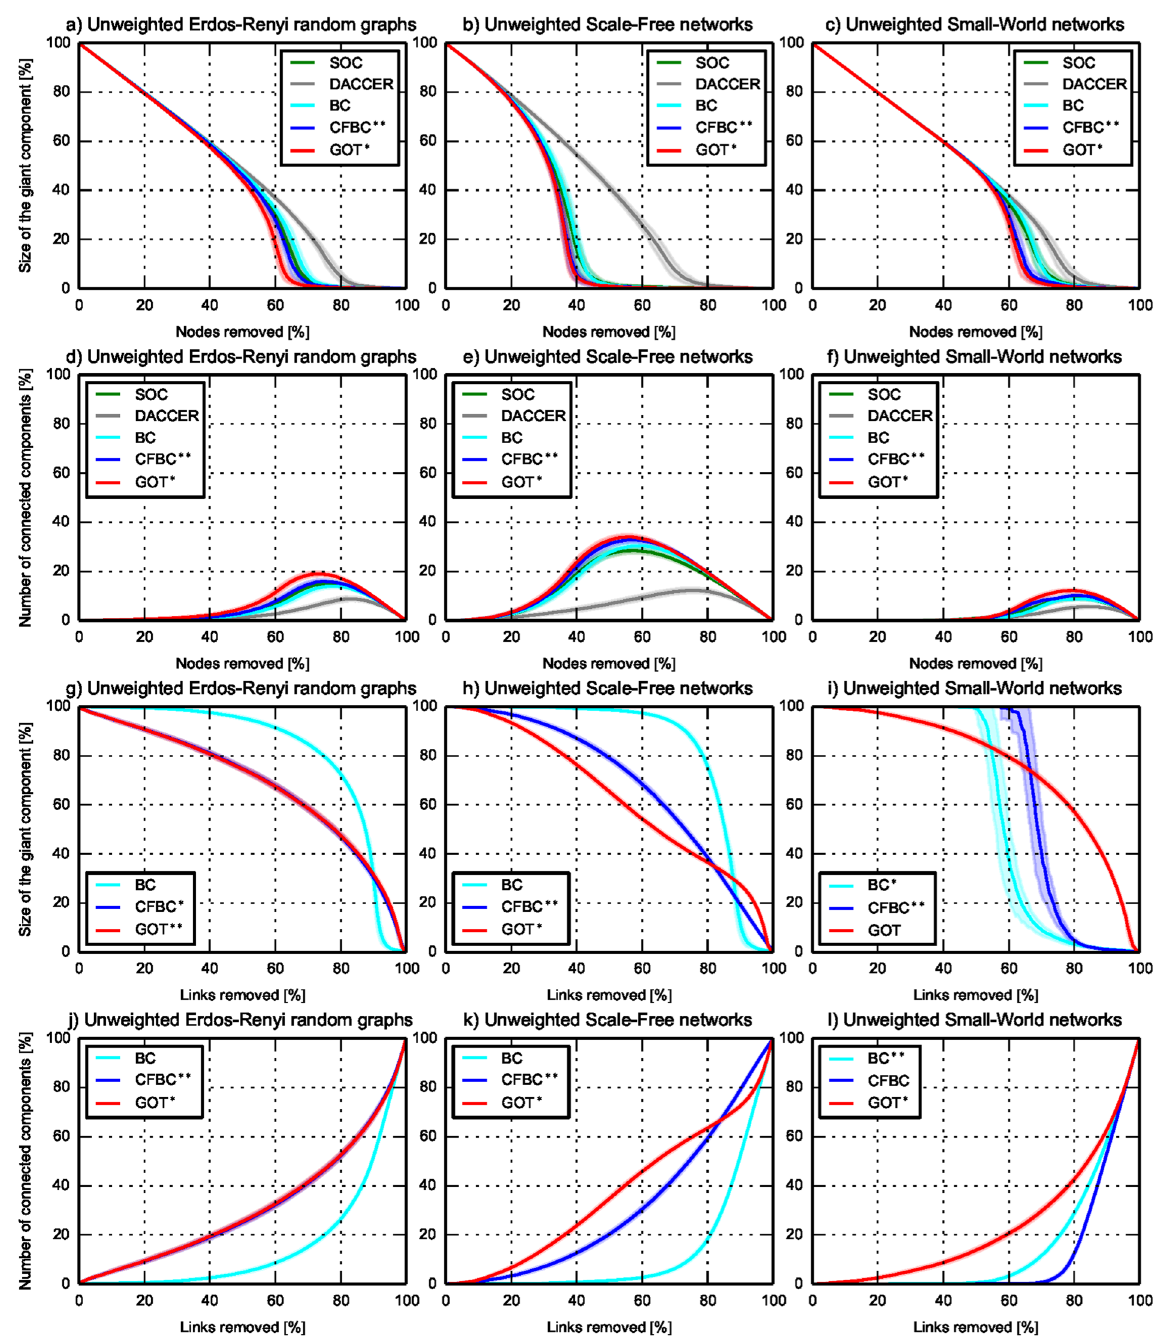
Figure 4. GOT accuracy - random generated unweighted networks. The evolution of the size of the giant component and of the number of connected components with mean (the straight line) and standard deviation (the shadow area) in unweighted networks during the NRP procedure, averaged over 100 networks in each subplot. The y-axes give figure of merit, while the x-axes represent percentage of node and links removals, respectively. In the top subplots, nodes centrality is assessed, while in the bottom subplots, the links centrality is